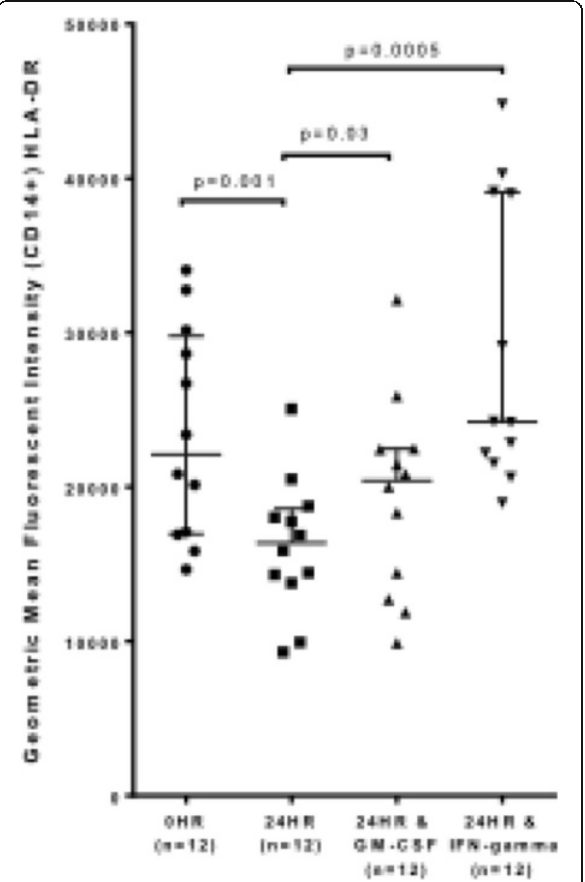
Fig. 19 (abstract A32). Effects of GM-CSG, INF γ on mHLA-DR geo- metric mean intesity in post-operative serum. Results are depicted in a dot plot with media and IQR, n=12, 3 independent experiments